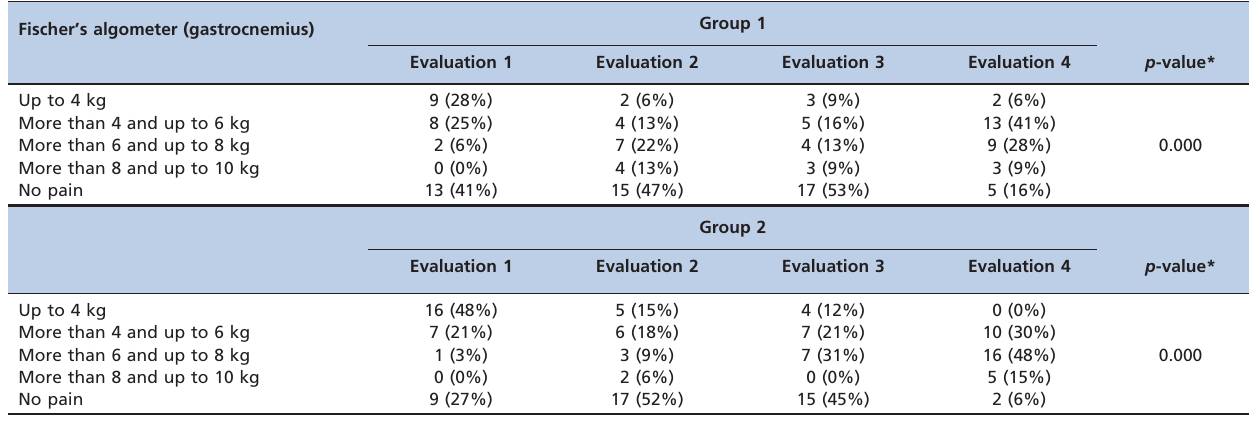
Table 5 - Distribution of patients according to Fischer’s algometer (gastrocnemius) in groups 1 and 2 before and after the treatment (immediately, three months and one year after the